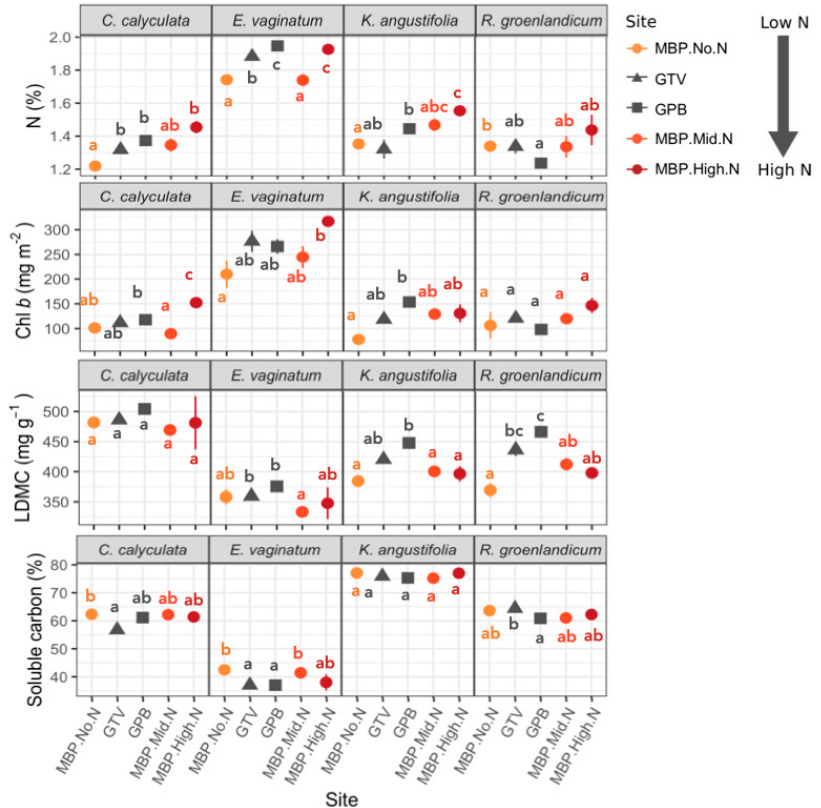
Figure 2. Mean ( ± standard error) functional traits per plant species and sites. N: nitrogen, LDMC: leaf dry matter content, Chl b : chlorophyll b . Colored points are from the Mer Bleue Peatland. Di ff erent shapes indicate measurements from di ff erent bogs, and di ff erent letters indicate significant di ff erences. N content in the soil increases among sites along the x-axis. Letters indicate di ff erences among groups within each panel ( p ≤ 0.05). Sample size for MBP.No.N = 23, GTV = 24, GPB = 24, MBP.Mid.N = 12, and MBP.High.N = 11 (see Figure 1 for description of site acronyms).